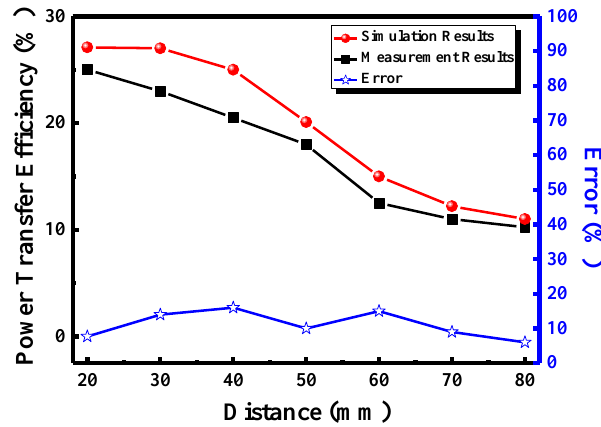
Figure 11. The measurement results of the four-coil MWPT system.